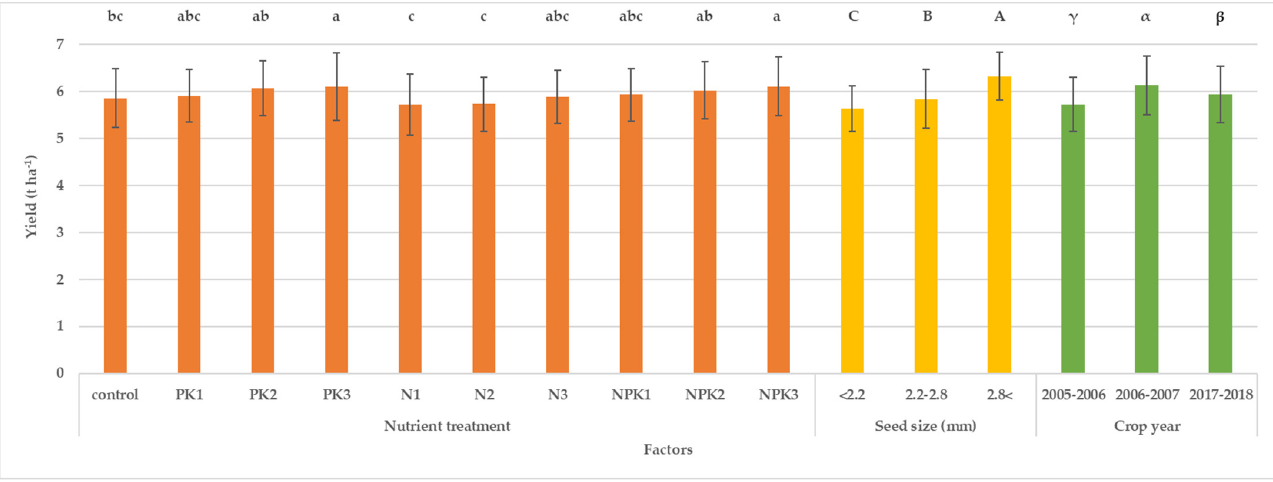
Figure 6. Effect of nutrient treatments, seed size and crop year on yield of winter wheat. (Values marked with different letters are significantly different at the p < 0.05 significance level. Small letters (a–c) represent nutrient treatments, capital letters (A–C) represent seed sizes and Greek letters ( α – γ ) represent years, where the order of the letters starts from the largest value. The standard deviation (SD) has been marked in the columns.)